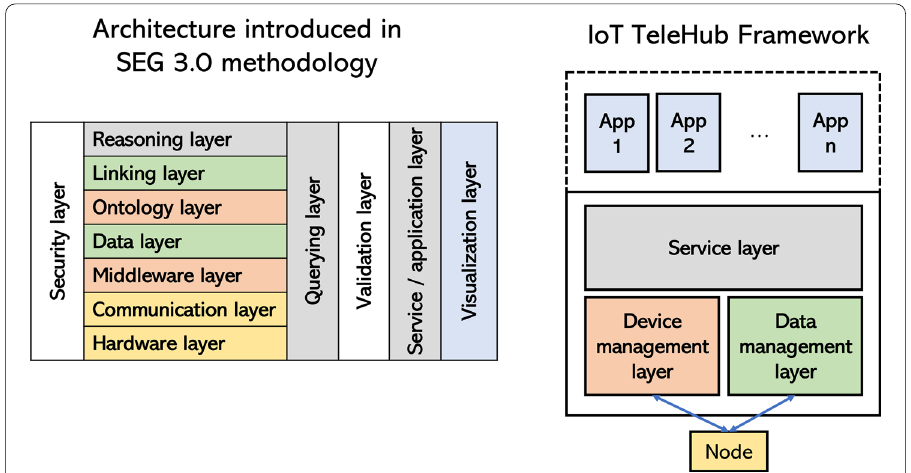
Fig. 6 Mapping of the proposed framework and the semantic interoperability architecture in